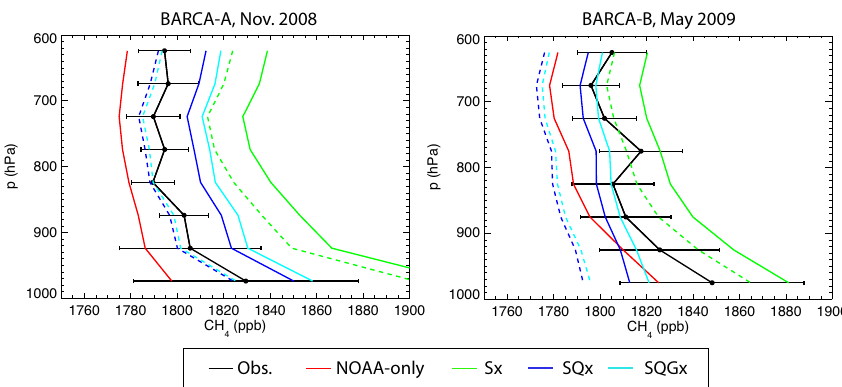
Fig. 9. Average vertical CH 4 pro fi les comparing simulations and measurements from the BARCA campaigns in November 2008 (left) and May 2009 (right). Black: Measurements with 1 σ standard deviations, Red: NOAA only, Green: S, Dark Blue: SQ, Light Blue: SQG. Solid lines are from ’ fi x’ scenarios, dashed from ’ fl ex’.